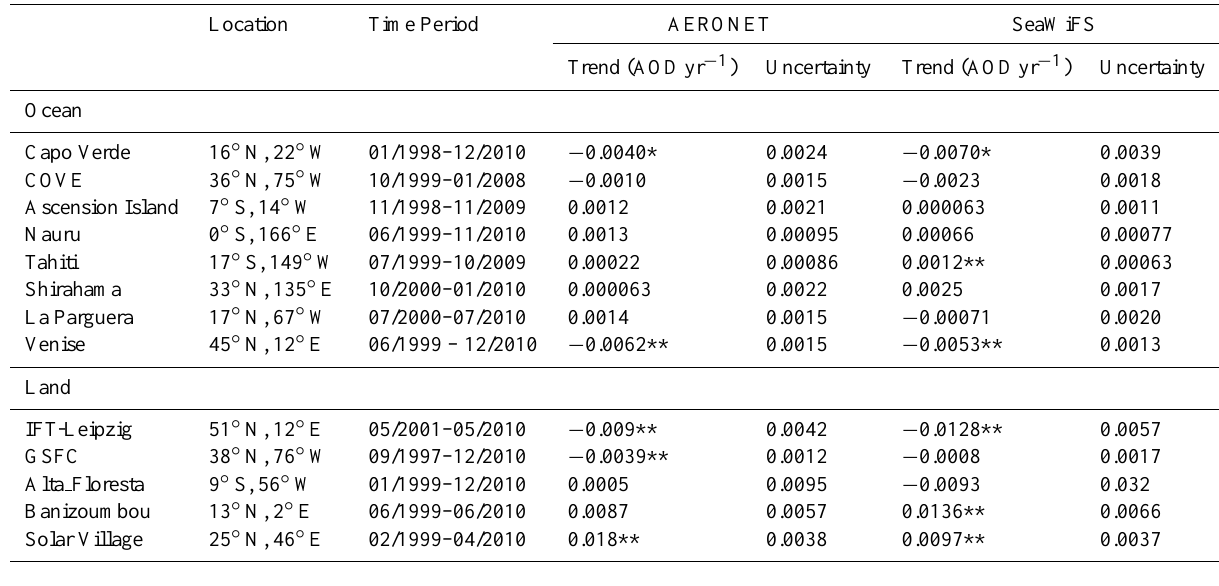
Table 2. Comparisons of SeaWiFS-derived annual trends with those from AERONET measurements. Quoted uncertainties are the 68% confidence limit. ** indicates trends significant at 95%, * indicates trends significant at 90%.